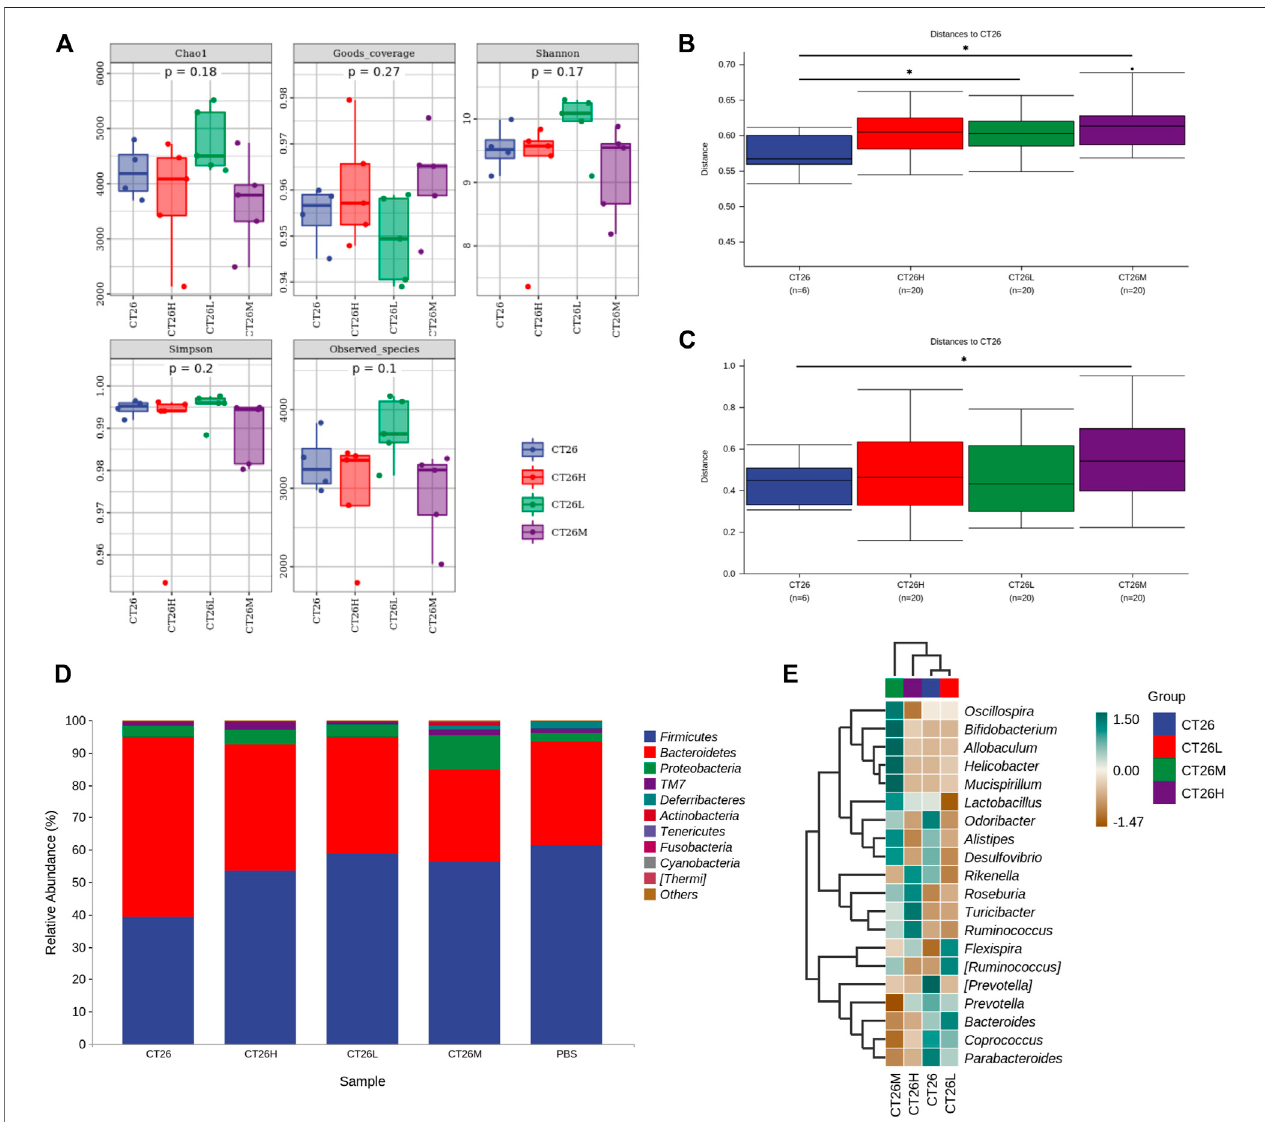
FIGURE5| GMdifferencesbetweentheCT26groupandtheFFCT-treatedgroups. (A) Diversityindexanalysis(Chao1,Good ’ scoverage,Shannon,Simpson,and Observed species) between the CT26 group and the FFCT-treated groups. (B) Differences in unweighted UniFrac distance between the CT26 group and the FFCT- treated groups. (C) Differences in weighted UniFrac distance between the CT26 group and the FFCT-treated groups. (D) Total gut bacterial relative abundance at the taxonomic rank of phylum. (E) Heat map of species composition of the gut microbiota in the CT26 group and the FFCT-treated groups at the genus level. * represents p <